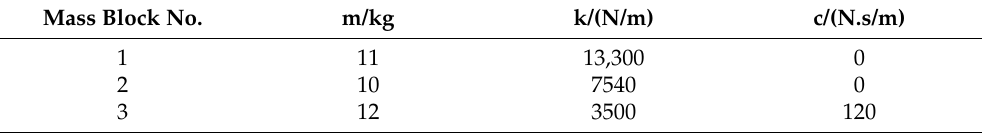
Table 5. Parameter input of the pantograph.